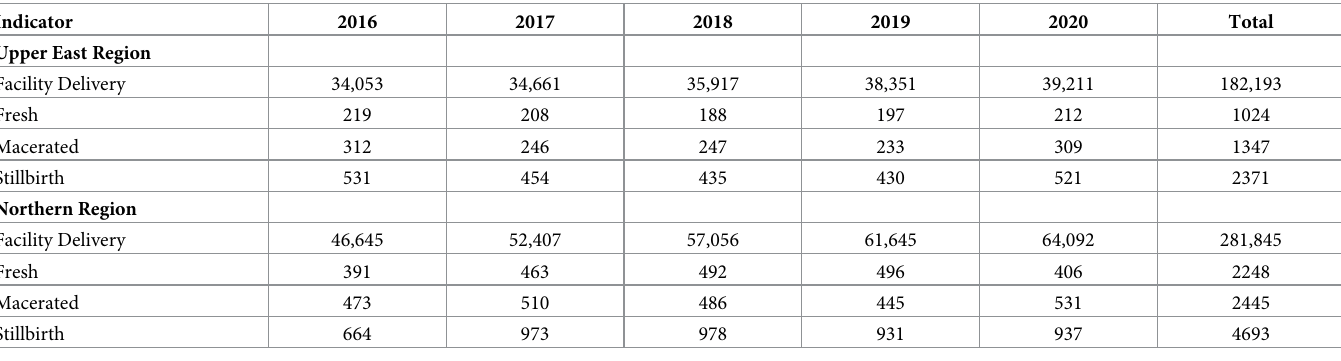
Table 1. Facility deliveries versus Stillbirth in the Upper East and Northern